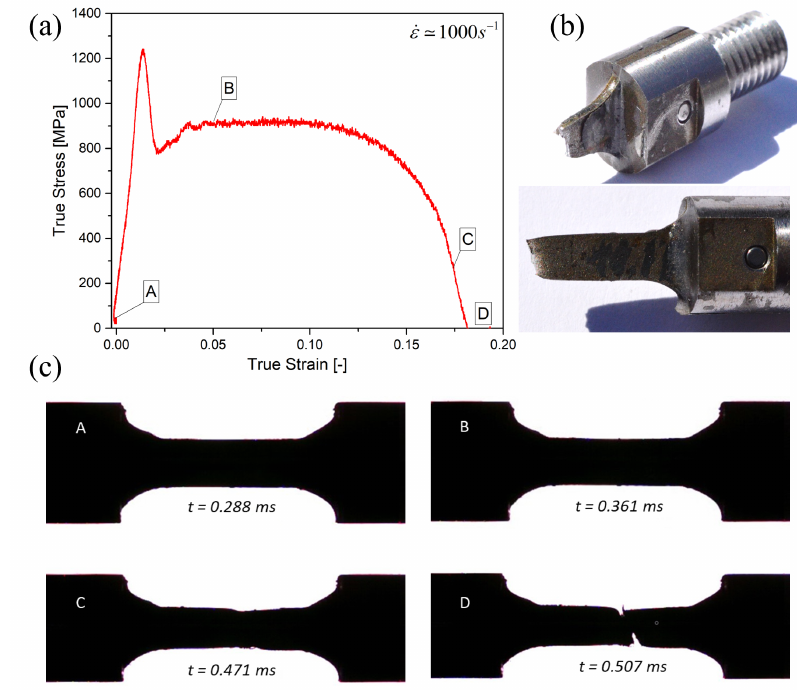
Figure 5. True stress over true strain curve for the 1000s − 1 test ( a ), failed specimen images, ( b ) and high frame rate camera frames ( c